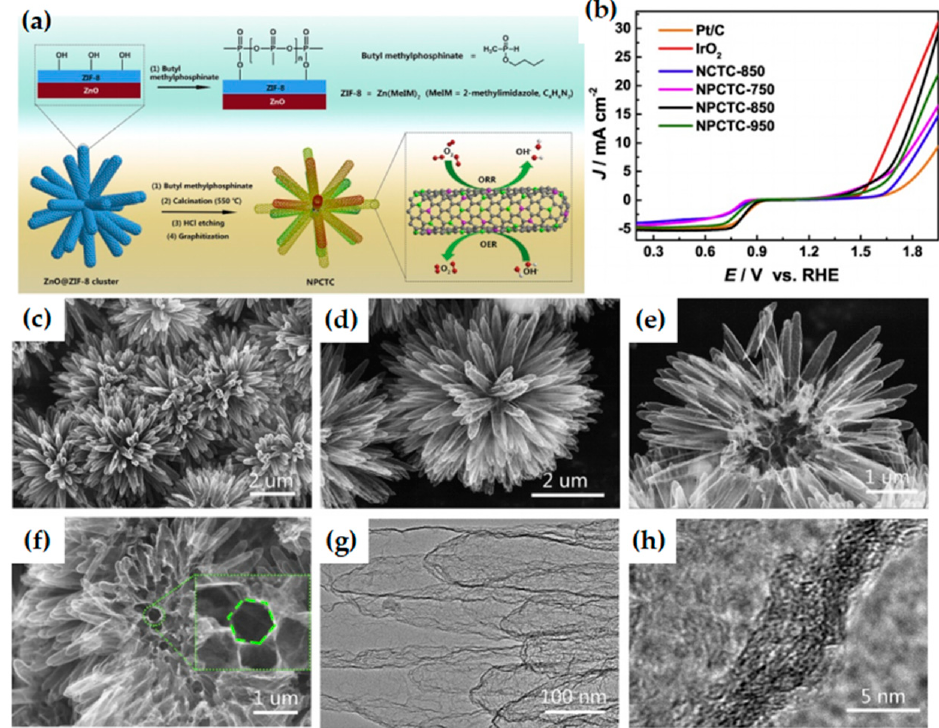
Figure 14. ( a ) Illustration of the preparation of NPCTC; ( b ) LSV curves of different catalysts for both ORR and OER at 1600 rpm in the whole ORR/OER region in O 2 -saturated 0.1 M KOH solution; ( c – f ) Typical SEM images of NPCTC-850; The inset in d shows the hexagon structural of single hollow carbon nanotube. ( g , h ) TEM images of NPCTC-850. Copyright 2018 Elsevier Ltd. All rights reserved [147].